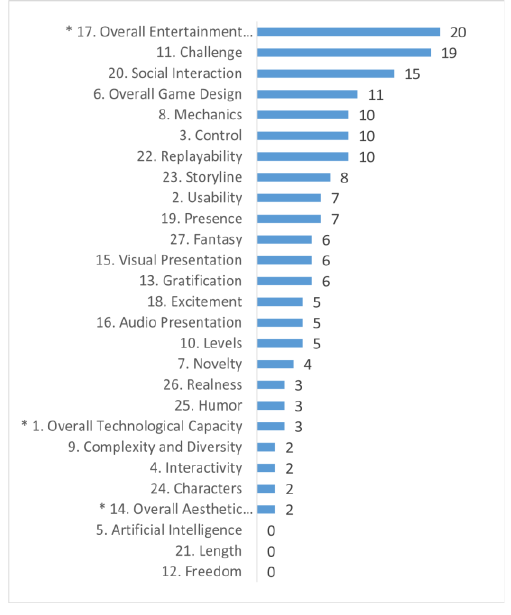
Figure 2. Frequency of the fun factors (constructs) in the